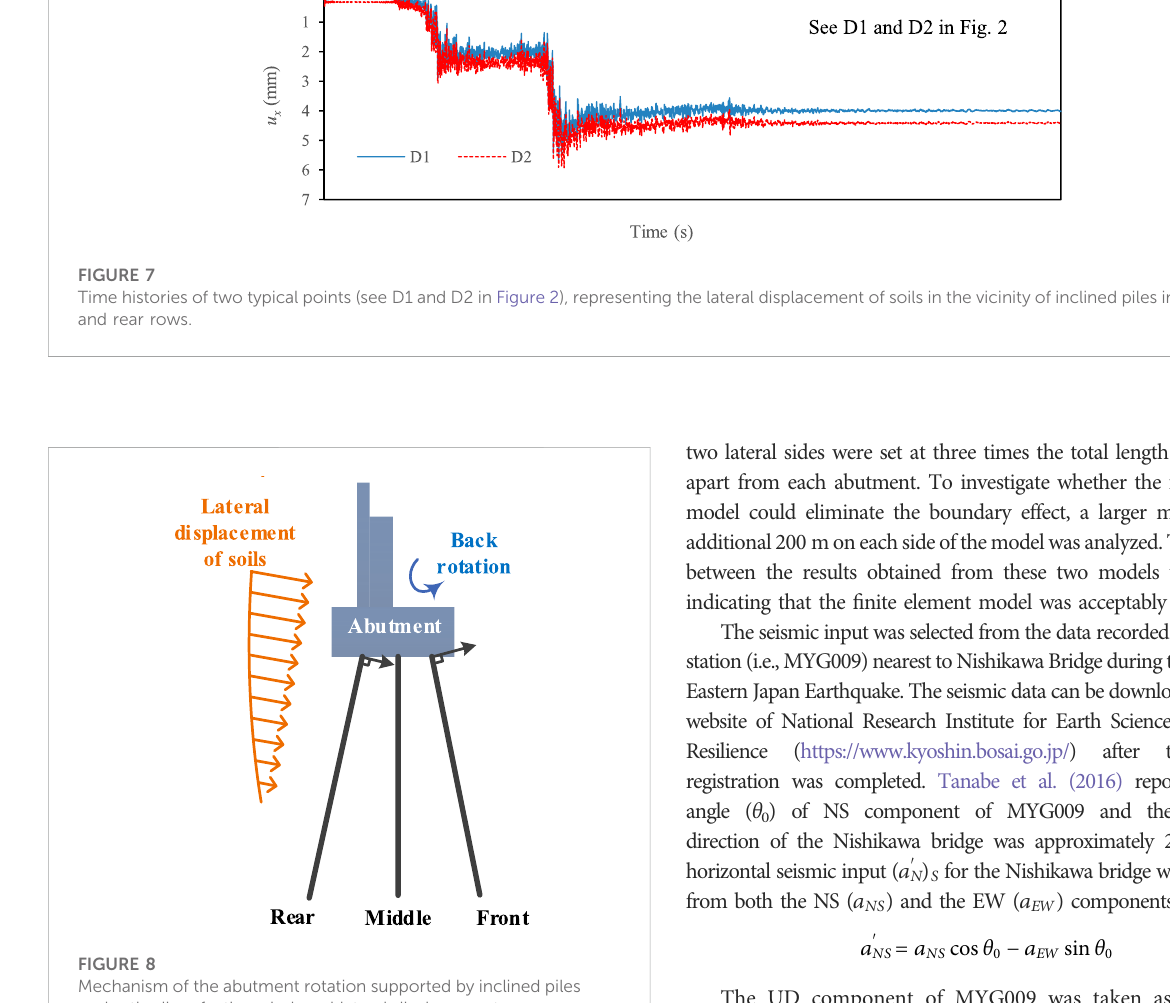
FIGURE 8 Mechanism of the abutment rotation supported by inclined piles under the liquefaction — induced lateral